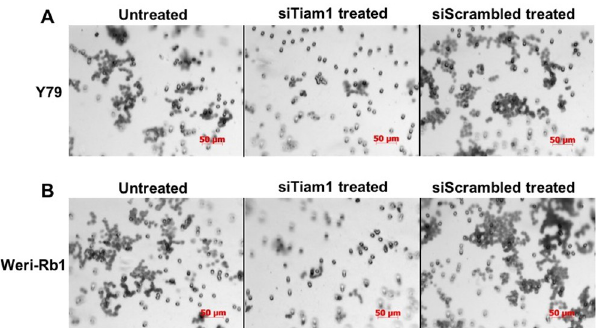
Fig 6. Matrigel invasion assay of Tiam1 deficient RB cell lines. A . Y79 panel showing the invasion of untransfected, siTiam1 treated and scrambled siRNA treated cells. B . Weri-Rb1 cells. The matrigel invasion chambers post invasion was stained with crystal violet and images acquired at 20 × objective. The experimental results were representative of triplicate result repeated twice.